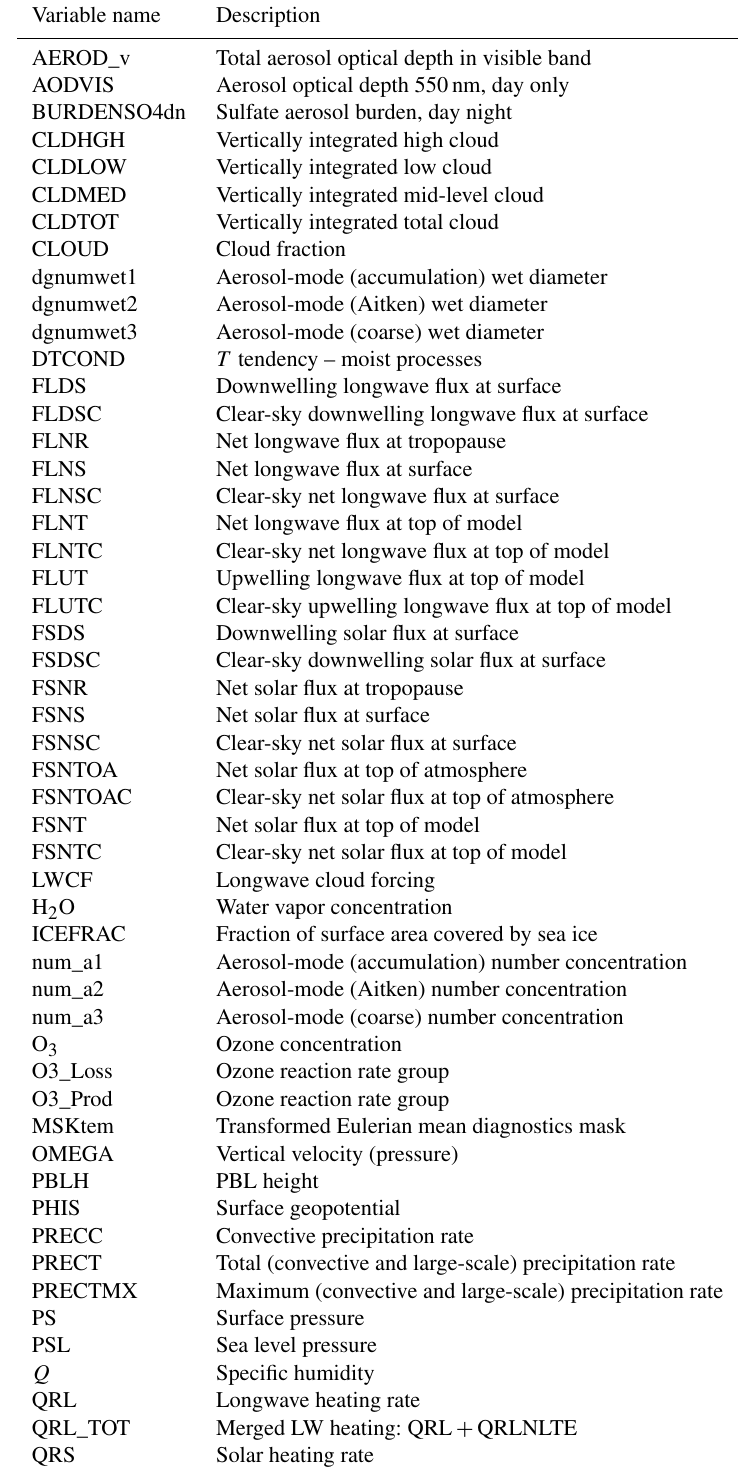
Table A1. Minimum recommended monthly mean output for ARISE-SAI simulations and corresponding reference